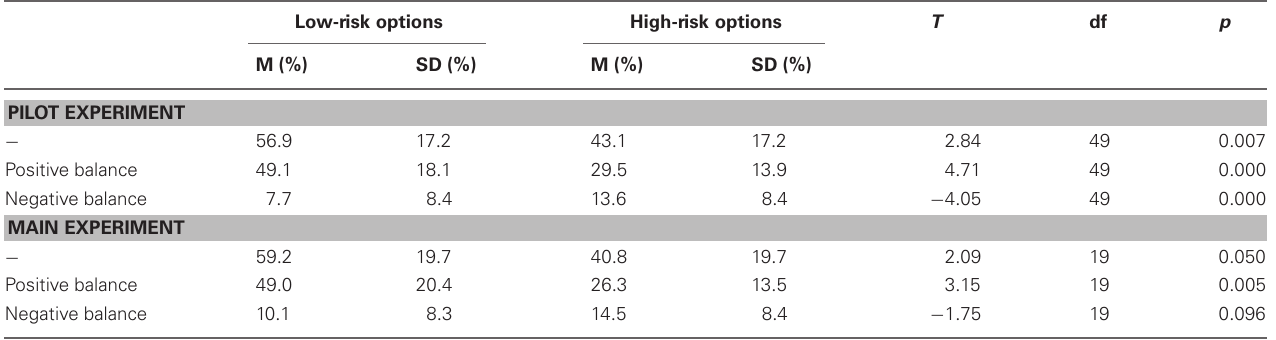
Table 2 | Behavioral results of the pilot experiment ( N = 50) and the main experiment ( N = 20) presenting mean (M) and standard deviation